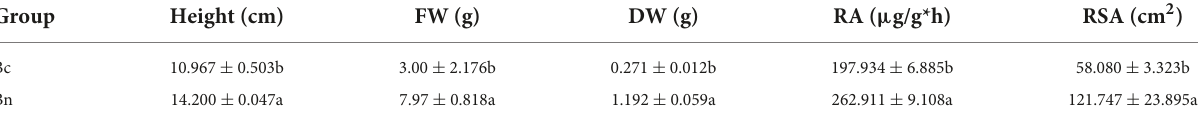
TABLE 2 Plant indicators for different groups.